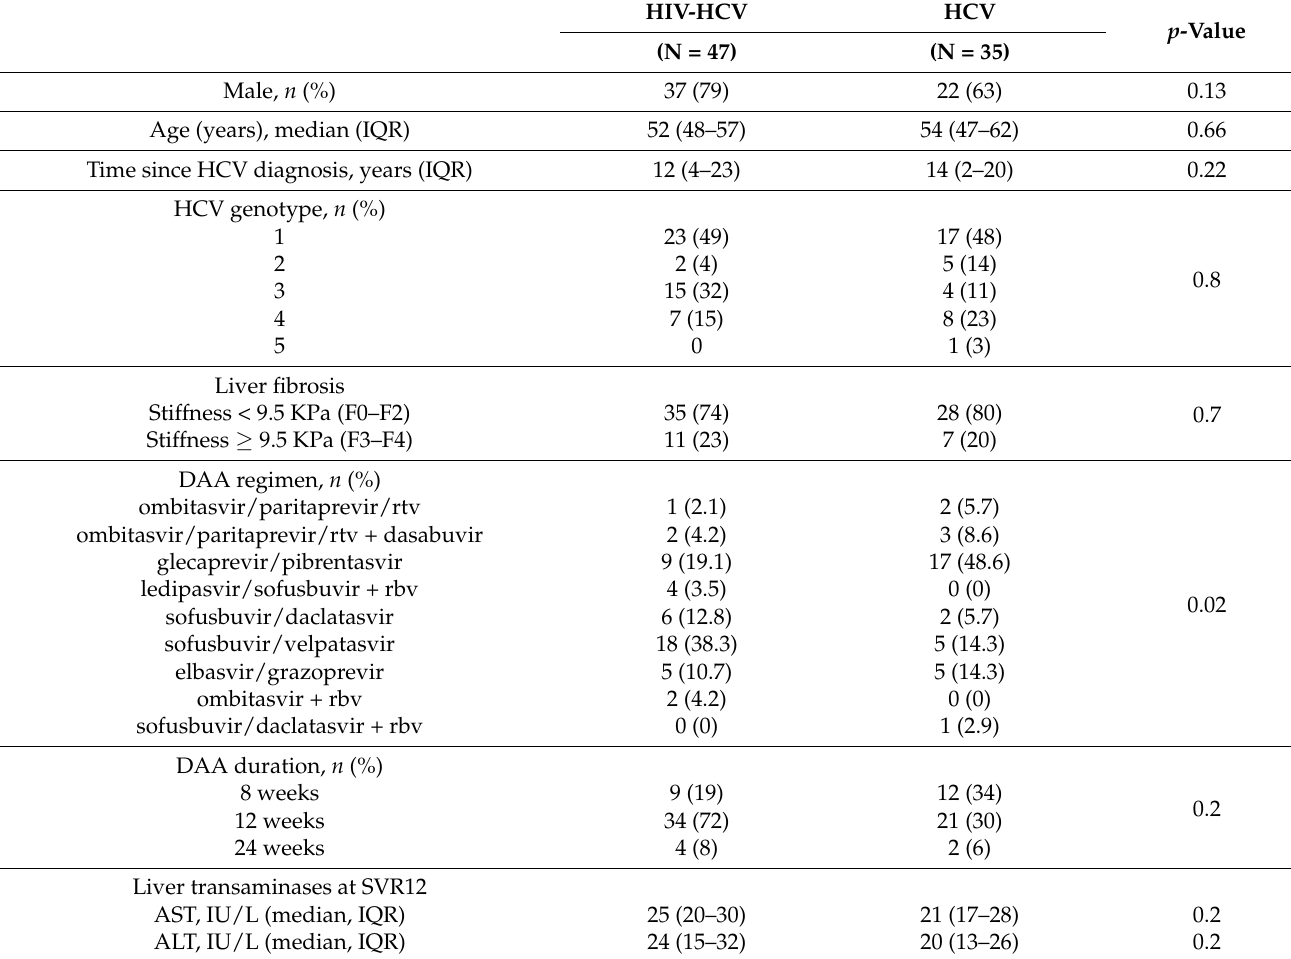
Table 1. Demographic and clinical characteristic of the study